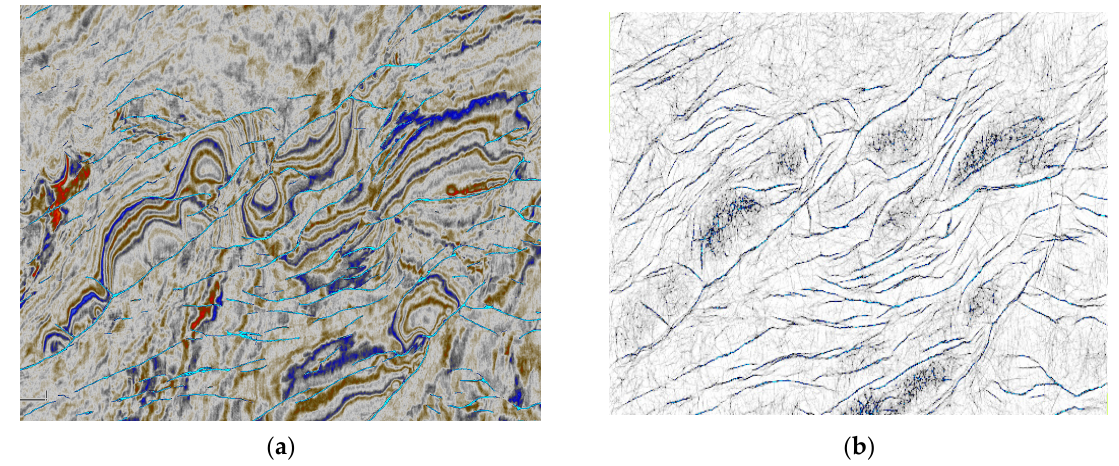
Figure 7. Fault detection using the ( a ) proposed and ( b ) conventional workflow. The proposed workflow generates clearer and simpler fault edges than conventional